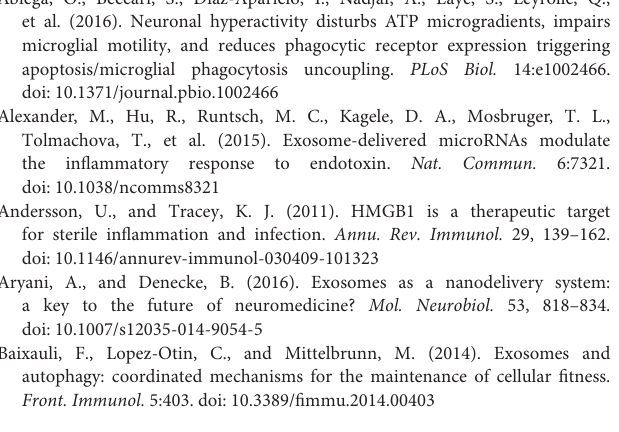
Figure S1 | Increased number of senescence-associated beta-galactosidase (SA- β -gal) expressing cells follows the exposure of N9 microglial cells to exosomes from mSOD1 NSC-34 MNs. N9 microglial cells were incubated for 2, 4, and 24 h with exosomes (Exos) from wild-type (wt)